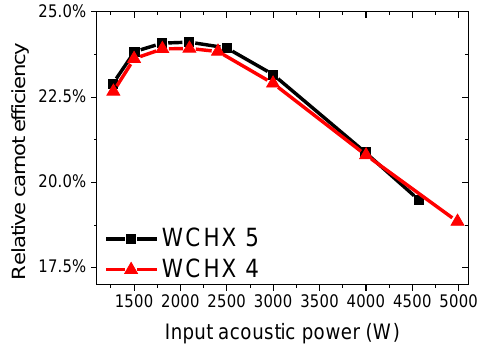
Figure 10. Dependence of relative Carnot efficiency on input acoustic power for WCHXs 4 and 5.